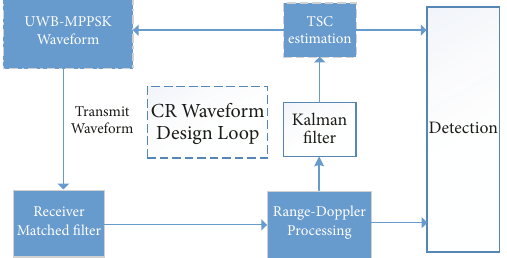
Figure 4: Cognitive waveform design feedback